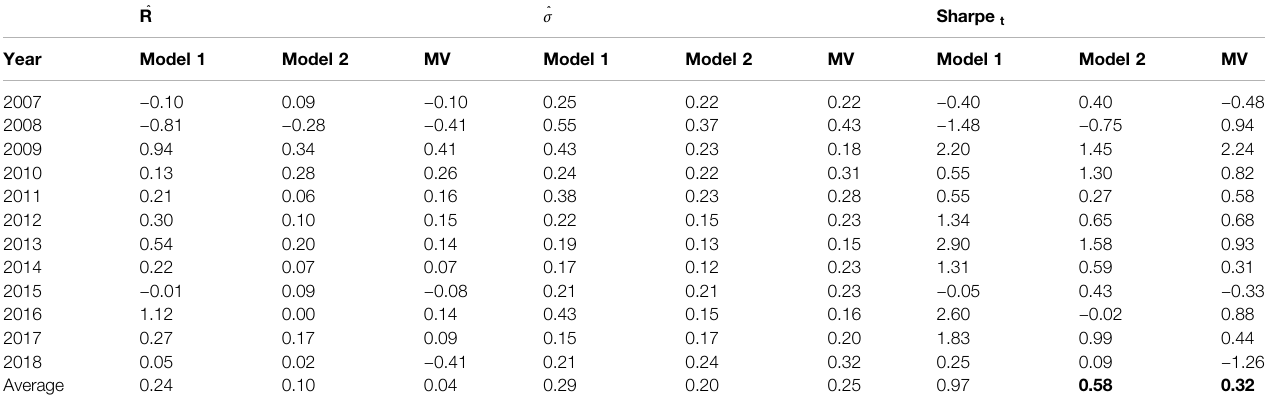
TABLE 1 | Performance